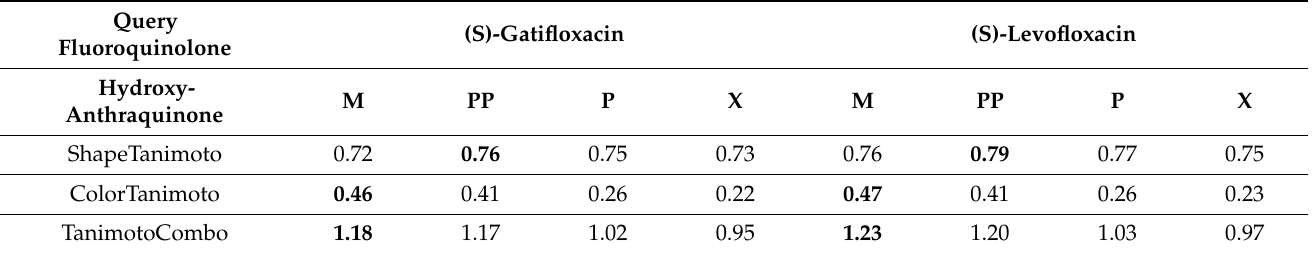
Table 1. Evaluation of shape- and chemical feature (“color”)-based similarity between the referent fluoroquinolones ((S)-gatifloxacin and (S)-levofloxacin), and the hydroxyanthraquinones—munjistin (M), pseudopurpurin (PP), purpurin (P), and xanthopurpurin (X). The highest similarity scores for shape, chemical features, and cumulative are